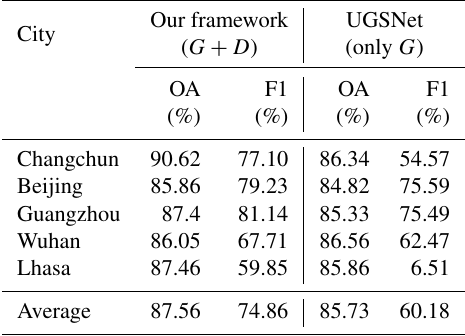
Table 6. Ablation study with the discriminator ( D